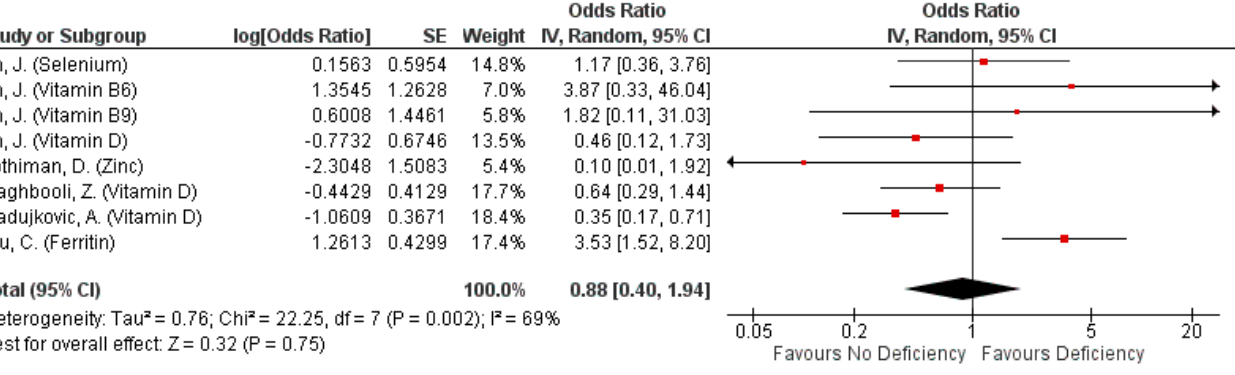
compared to those deficient in any micronutrient singly.